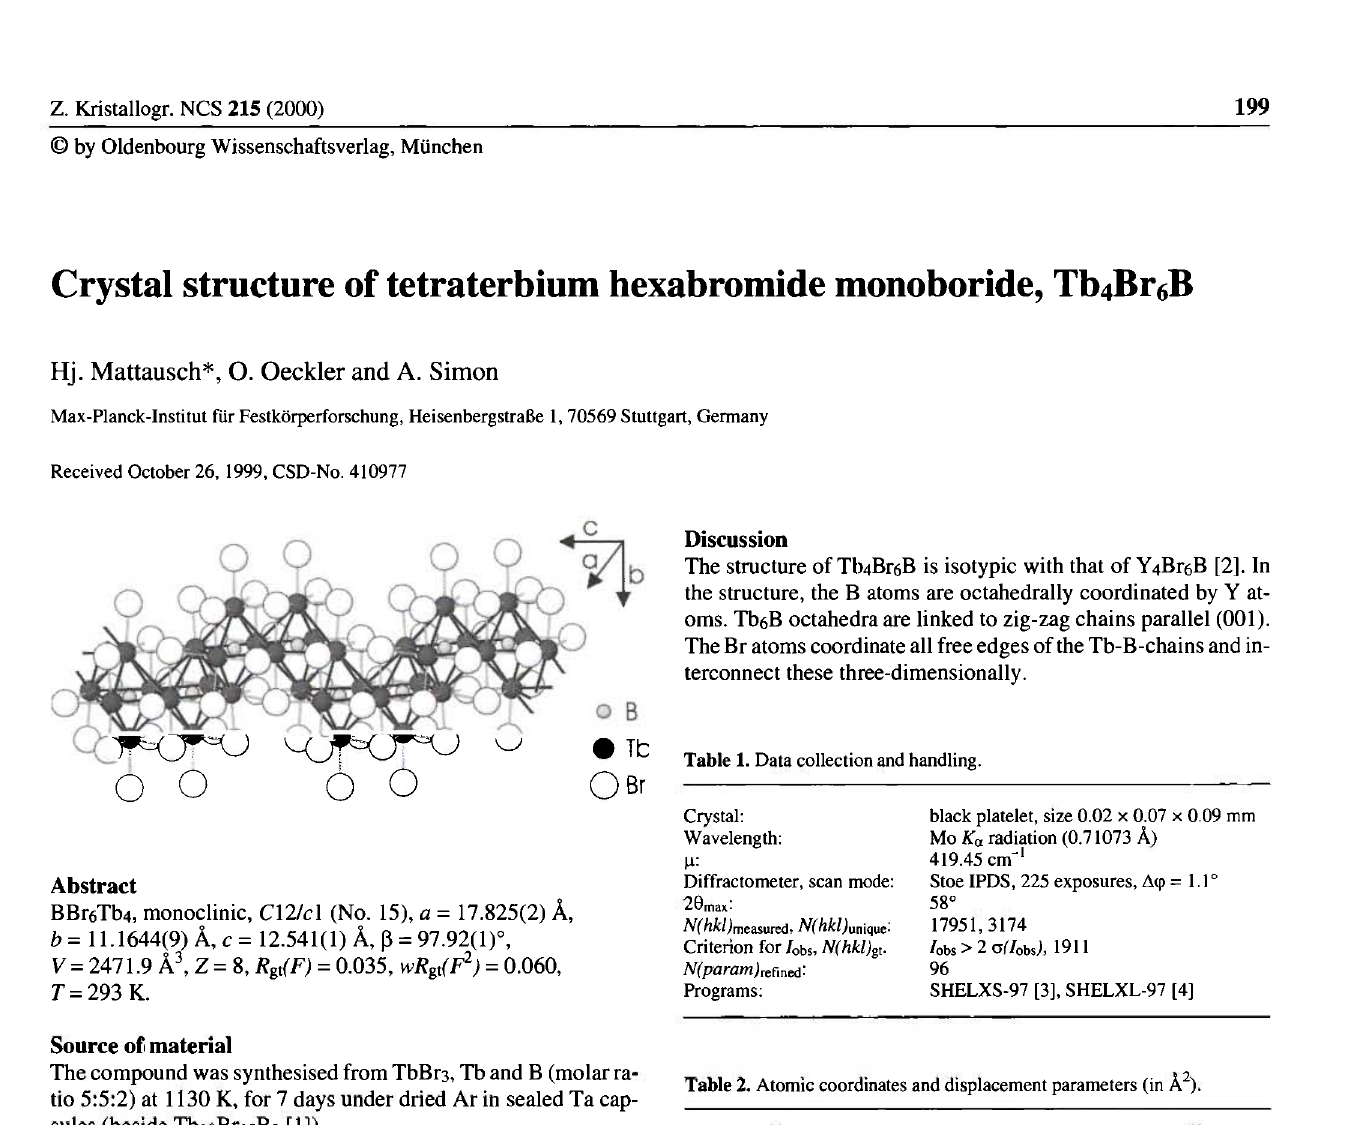
Table 2. Atomic coordinates and displacement parameters (in A 2 ).